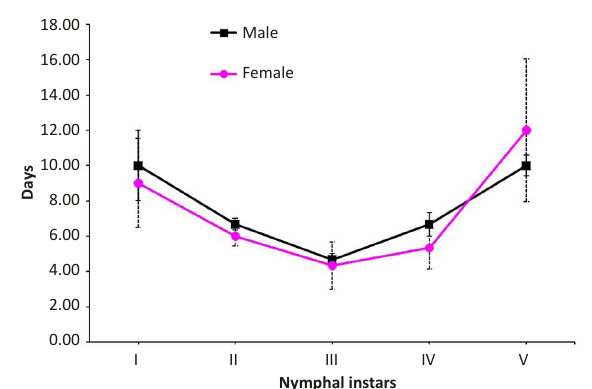
Figure 1. Developmental period of C. gilvus male and female (mean ± SE)